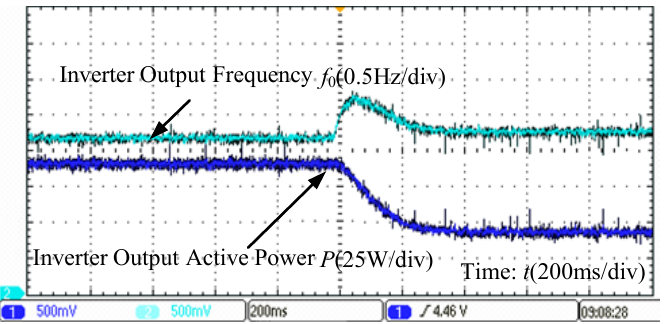
Figure 22. The output active power and frequency of the inverter when the damping coefficient D = 5.67 in a weak grid.